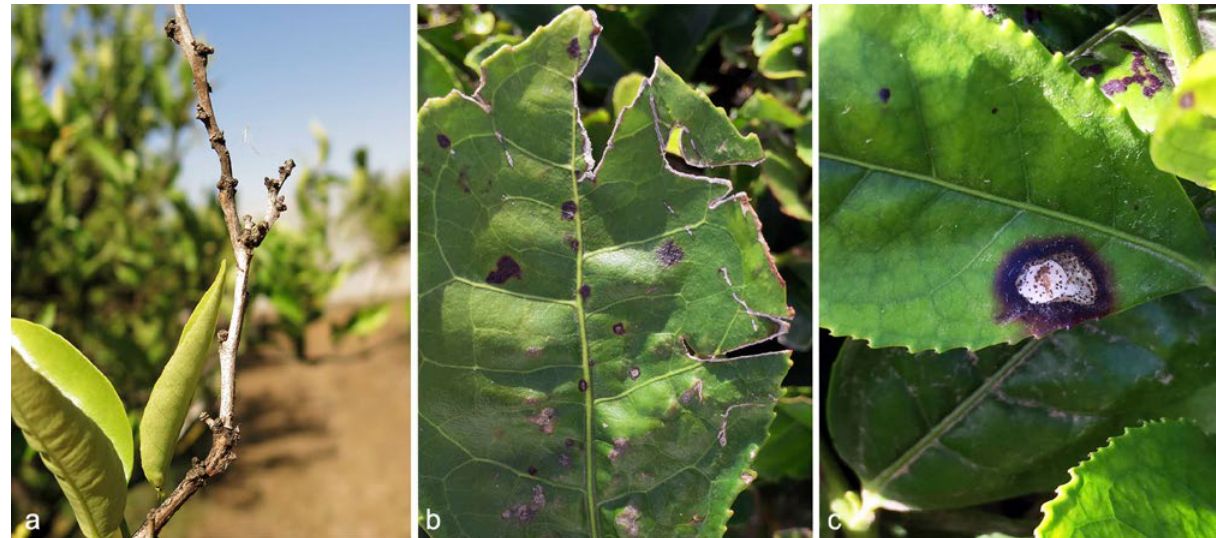
Figure 1. Symptoms on plant tissues with associated Diaporthe spp. (a) Shoot blight on Citrus reticulata with conidiomata of D . citri . (b–c) Leaf spot of Camellia sinensis with visible D . portugallica